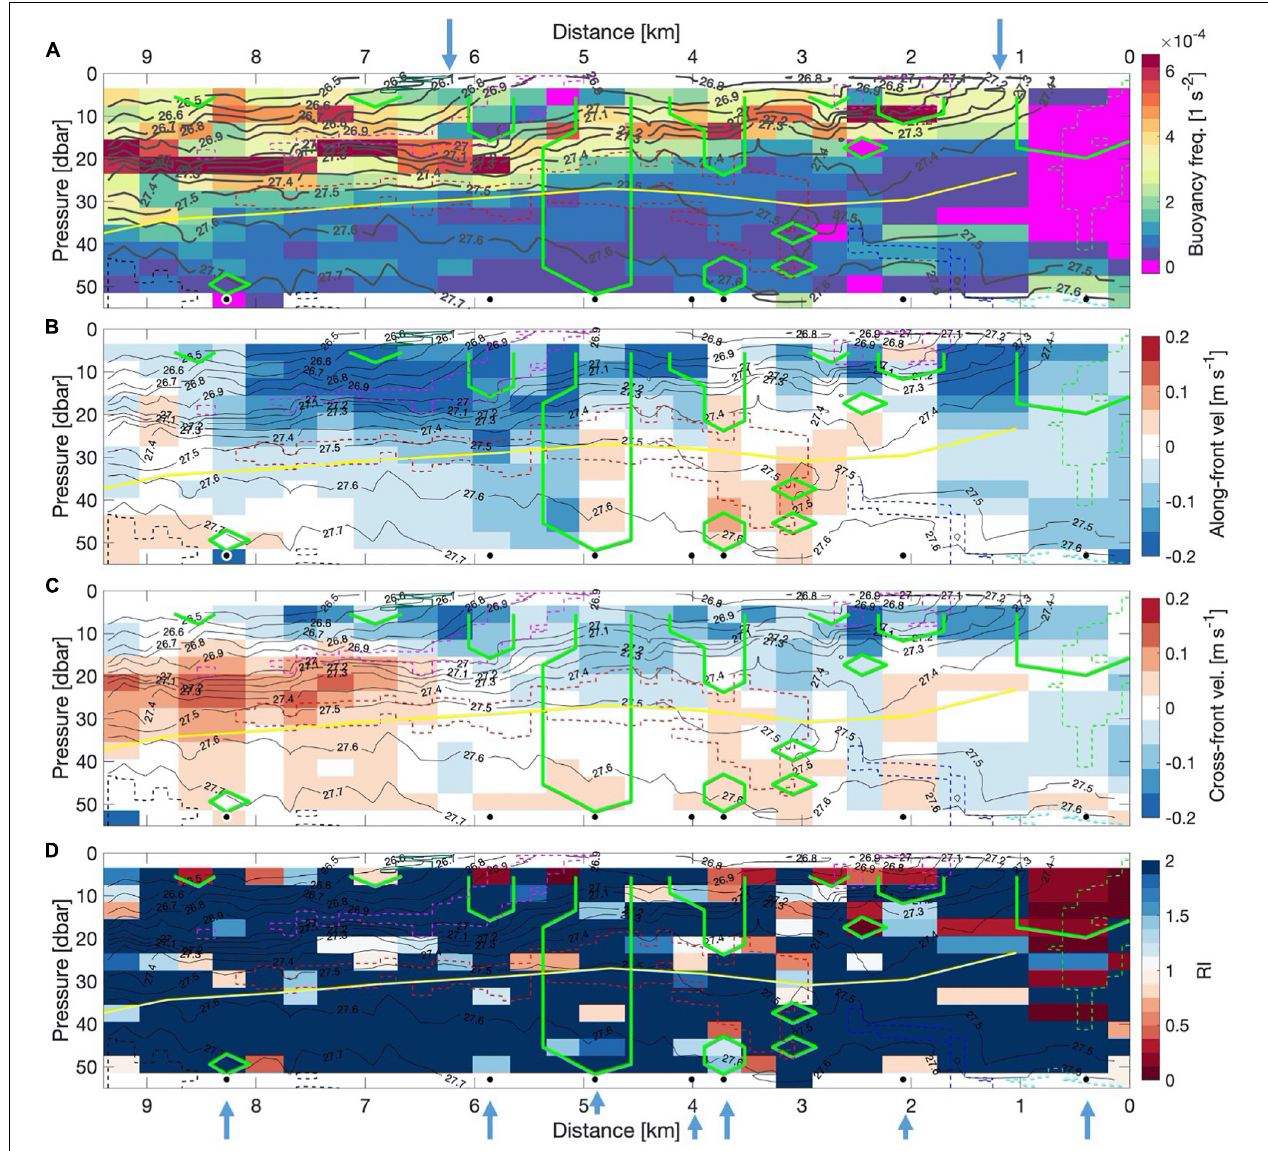
FIGURE 4 | (A) Buoyancy-frequency N 2 (s − 2 ) from upward and downward profiles of the AUV computed over 4 m bins, (B) Along-front velocity component (ms − 1 ) computed over 4 m bins. Blue colors indicate south-westward velocities (out of the page). Red colors indicate north-eastward velocities (into the page). (C) Cross-front velocity component (ms − 1 ) computed over 4 m bins. Red colors indicate north-westward velocities (towards the left of the plot). Blue colors indicate south-eastward velocities (towards the right of the plot). (D) Richardson Numbers (colored circles) computed over 4 m bins. All: Black contour lines indicate potential density. Yellow line indicates the euphotic depth. Colored, dashed contour line-boxes indicate different water masses (compare Figures 2 , 3 ). The thick green contour line indicating areas with negative Ertel potential vorticity. Blue arrows at the top indicate the position of the two fronts. The black dots at 53 m and the blue arrows mark the locations of the single profiles shown in Figure 5